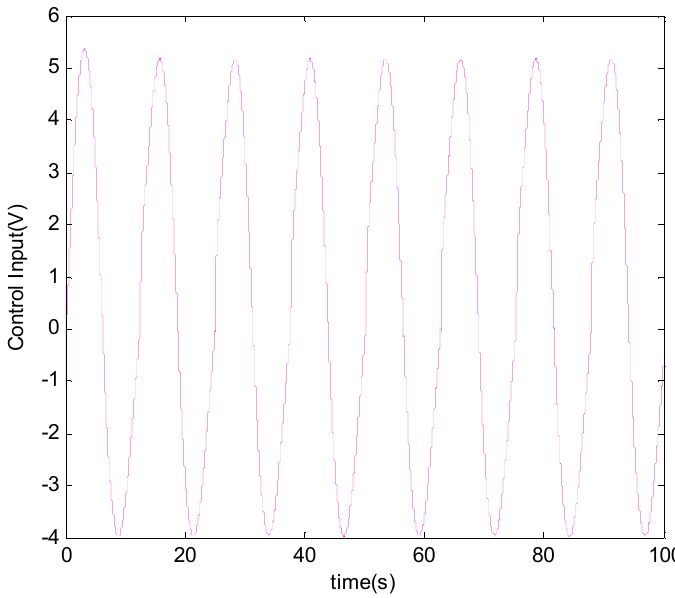
Figure 8. The control input of ARCBF as ε = 1 × 10 − 6 .